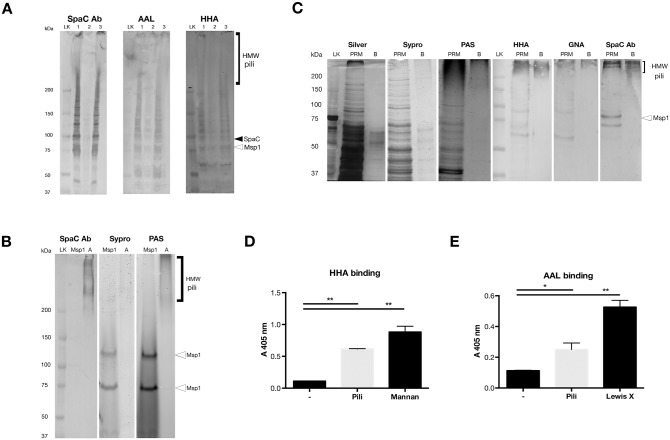
SpaCBA pili are glycosylated with mannose and fucose.(A) SpaCBA pili are glycosylated on L. rhamnosus GG cells—Cell wall-associated proteins of L. rhamnosus GG wild type (1), the pilus-deficient ΔspaCBA::TcR mutant (CMPG5357, 2) and the ΔwelE::TcR mutant on which the pili are overexposed (CMPG5351, 3), were probed with mannose- and fucose-specific lectins (HHA and AAL resp.). Pili content was visualized by probing with SpaC antiserum (SpaC, black arrow and HMW: high molecular weight pili). Interference of the Msp1 glycoprotein was ruled out (open arrow). Blots and gels were performed in triplicate. (LK = Precision Plus Protein™ Kaleidoscope™ Standard, Bio-Rad) (B) Purified pili are glycosylated—SDS-PAGE separated pili (pool A) were stained with PAS glycostain and Sypro® to visualize their protein content. Pili content was shown by probing of Western blotted samples with SpaC antiserum (HMW: high molecular weight pili). Purified Msp1 (open arrow) was used as a positive control. Representative gels are shown, experiment was carried out in triplicate. (LK = Precision Plus Protein™ Kaleidoscope™ Standard, Bio-Rad) (C) SpaCBA pili bind mannose-specific lectins—Purified pili fractions (PRM and pili pool B) were subjected to PAS glycostaining and both Sypro® and Silver stain to visualize their protein content. Absence of 75 kDa signals on PAS and lectin blots rule out the interference Msp1 (cf. open arrow). Western blotted samples were probed with SpaC antiserum (HMW: high molecular weight pili) and the mannose-specific lectins HHA and GNA, visualizing the pili content of the samples and the presence of mannose, respectively. Representative gels and blots of in triplicate-repeated experiment. (LK = Precision Plus Protein™ Kaleidoscope™ Standard, Bio-Rad) (D&E) Mannose- and fucose-specific lectins bind SpaCBA pili—Binding of lectins to plate-coated pili was measured to ELISA. Wells coated with coating buffer served as a negative control. Mannan and Lewis X were coated as a positive control for the mannose-specific HHA (Hippeastrum hybrid, D) and fucose-specific AAL (Aleuria aurantia, E) lectins, respectively. Error bars represent standard deviations of three independent experiments (paired t-test, p < 0.05)